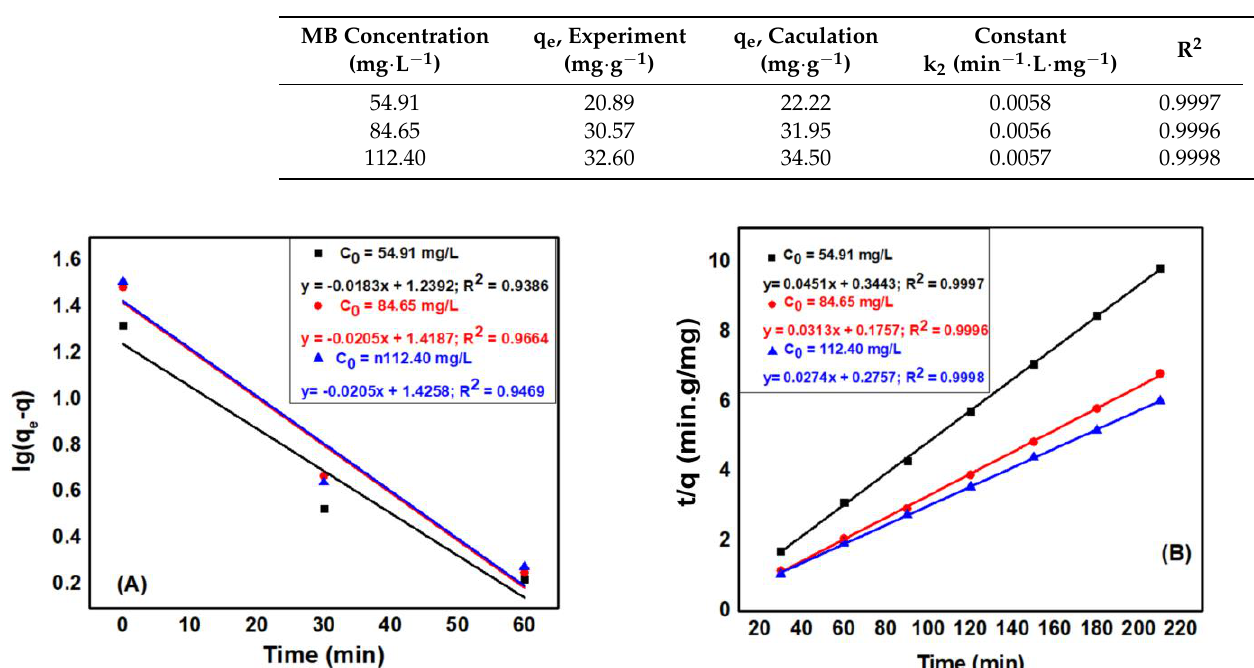
Figure 12. ( A ) The pseudo − first-order adsorption kinetics equation and ( B ) The pseudo-second-order adsorption kinetic equation .